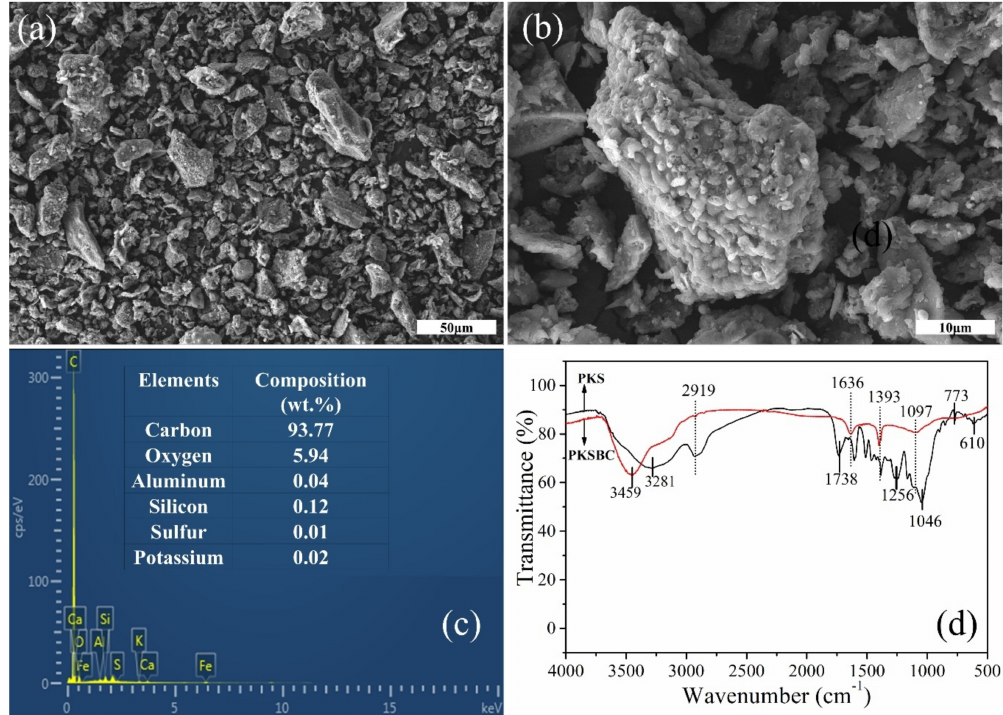
Figure 5. SEM images of PKSBC at di ff erent magnifications of 16k ( a ) and 60k ( b ), elemental composition of PKSBC ( c ), and FTIR spectrum of PKS and PKSBC ( d